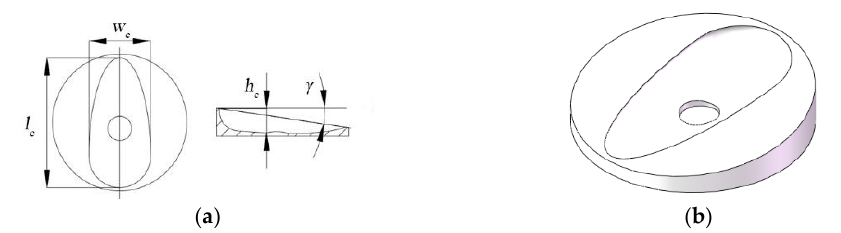
Figure 8. Schematic diagram of the seed suction groove: ( a ) The dimensions of the seed suction groove; and ( b ) 3D view of the seed suction groove.